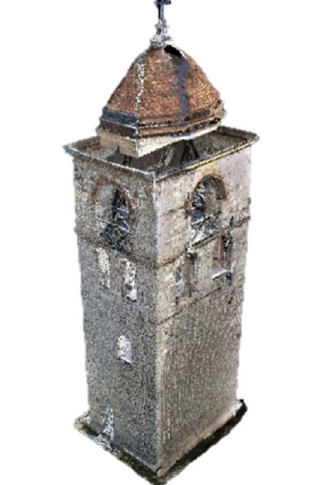
Figure 5 - Points Cloud of the